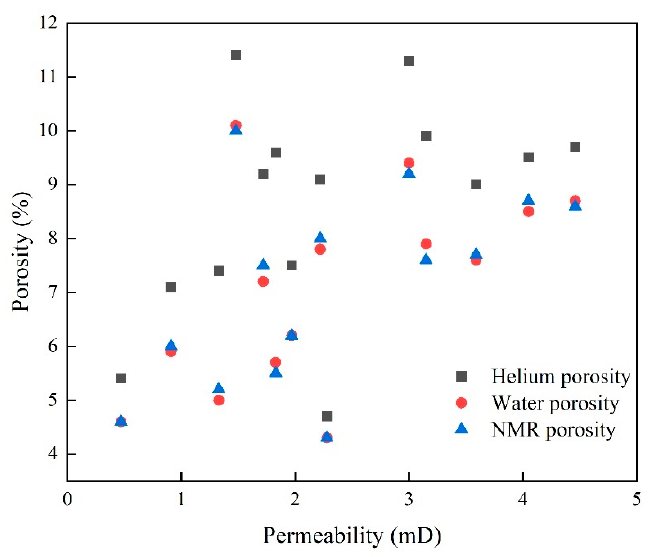
Figure 6. Correlations of permeability vs. helium porosity, NMR porosity and water porosity.